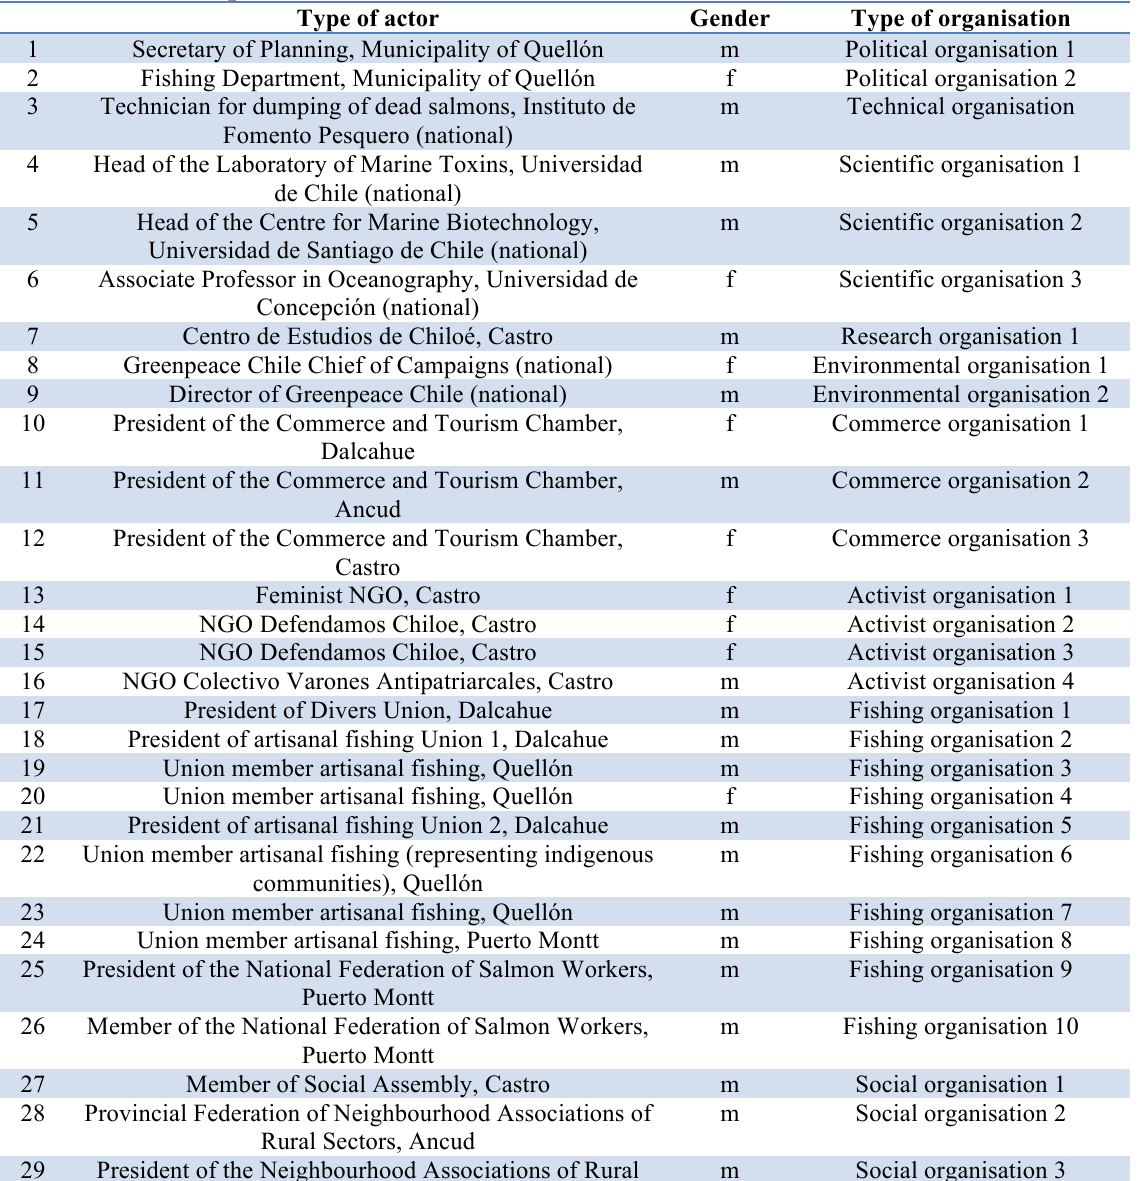
Table A1.2 In-depth